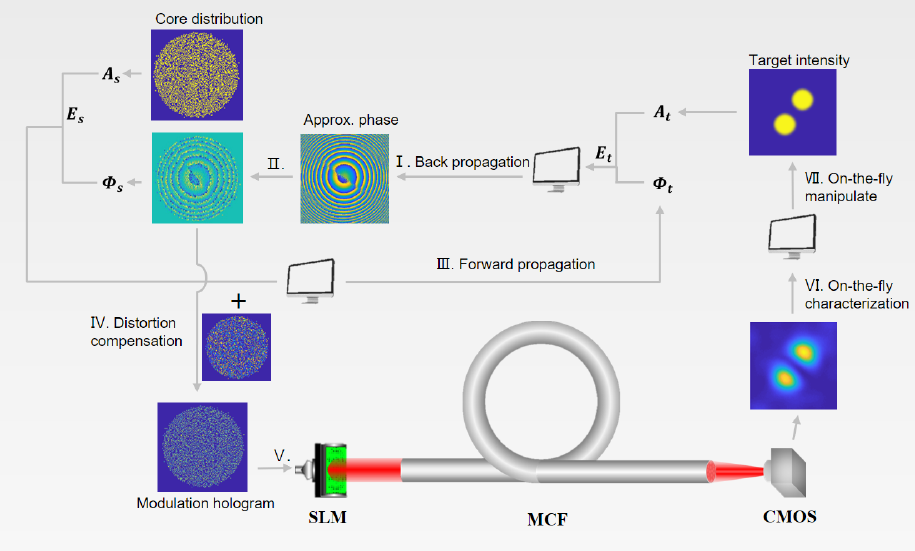
Figure 6. Principle of the on-the-fly closed-loop control with Core-GS algorithm. To achieve two intensity-balanced spots at distal side of the MCF, the calculated phase image at the source plane and the distortion compensating phase image constitutes the modulation hologram which is displayed on the SLM in real-time. The modulated light transmits through the MCF and the dual-spot intensity profile is captured by the distal CMOS camera, and the intensity difference between the two spots is on-the-fly evaluated and determines the targeted amplitude image for the next